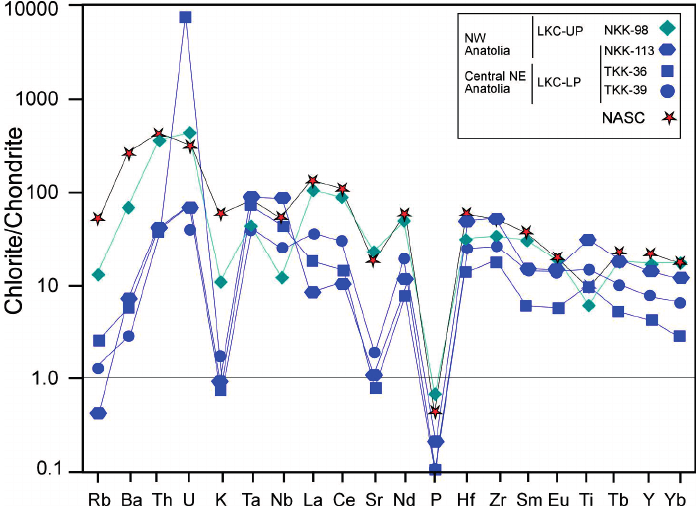
Figure 13. Chondrite-normalized trace element pattern of chlorite minerals in the Karakaya Complex units (Chondrite: Sun and Mcdonough [53]; Nb and Y for North American Shale Composite (NASC): [51]; other elements: Gromet et al.